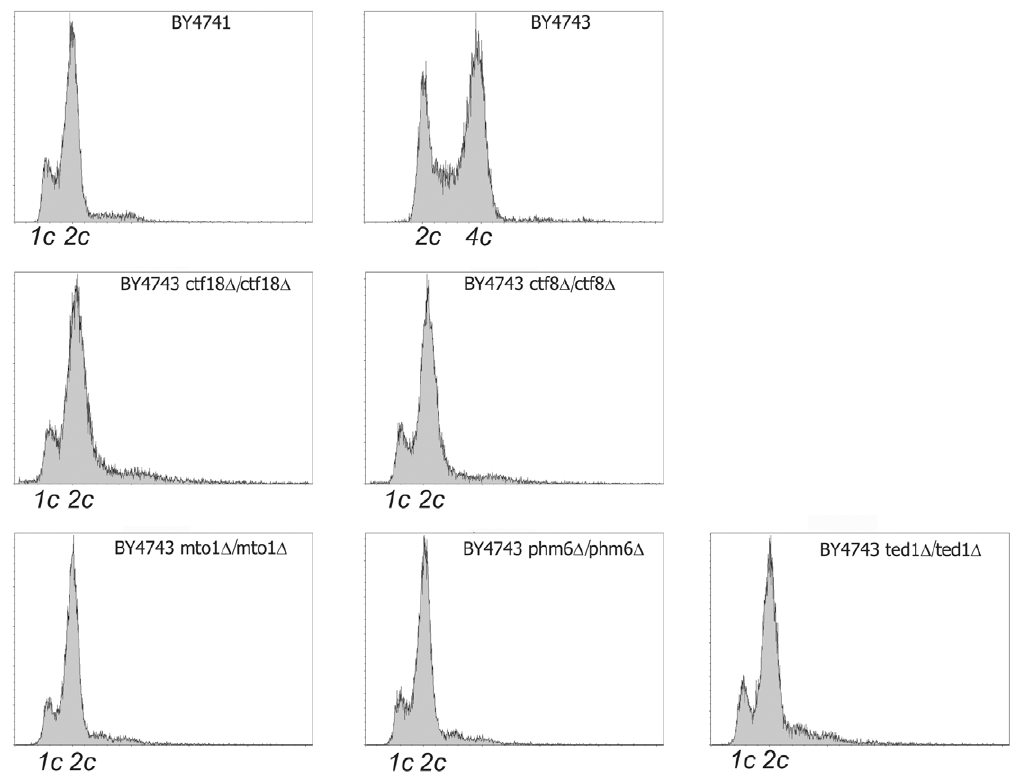
Figure 3. DNA content analysis of mutator strains in BY4743 background from homodiploid YKO collection. DNA content analysis of ctf18 D /ctf18 D , ctf8 D /ctf8 D , mto1 D /mto1 D , phm6 D /phm6 D and ted1 D /ted1 D strains in BY4743 background from homodiploid YKO collection. Wild- type BY4741 (1n) and BY4743 (2n) strains served as controls for DNA content. Propidium iodide stained cells were analyzed by FACS as described in Materials and Methods.